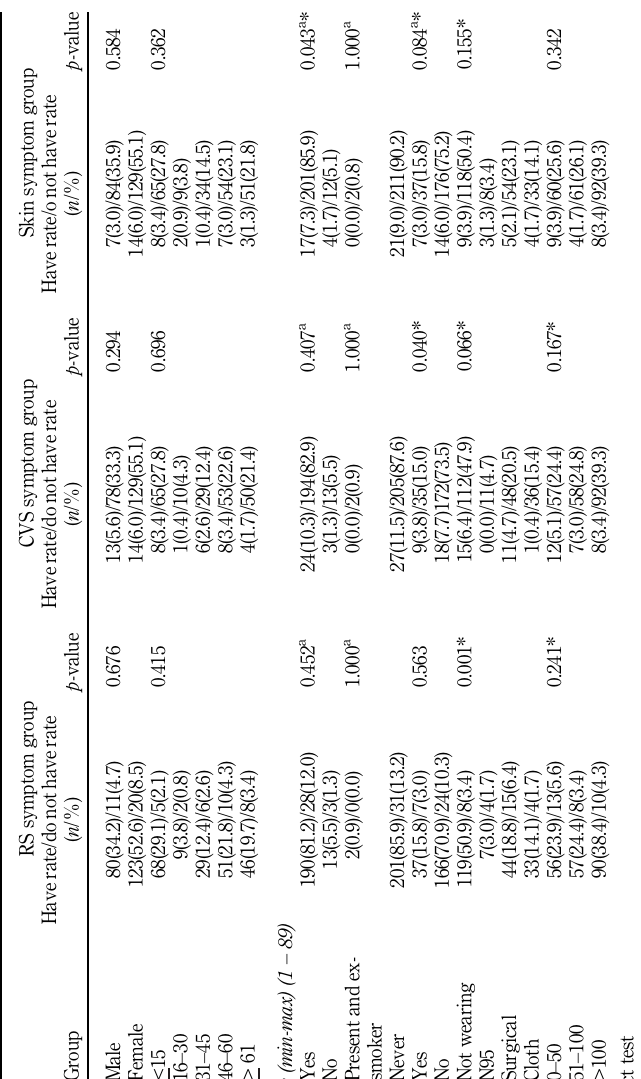
Table 1. Comparison of have/do not have a rate of symptom-related air pollution among participants in different symptom groups ( n 5